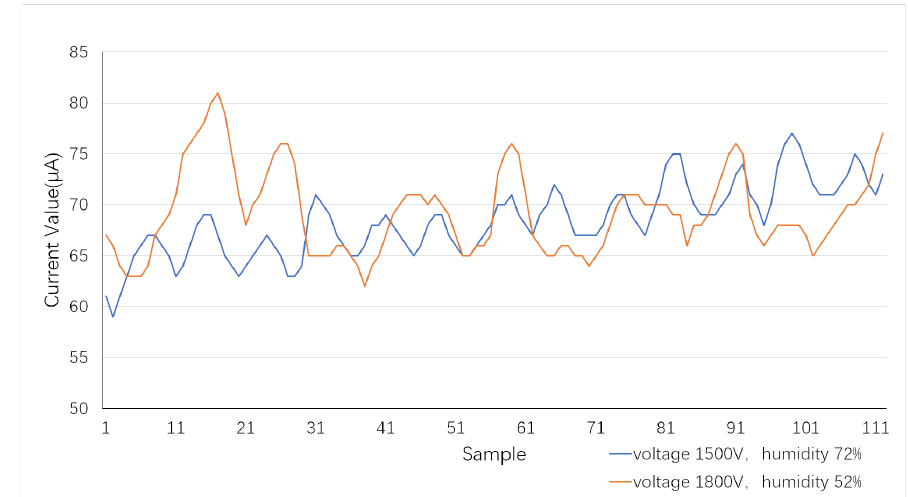
Figure 10. Standard deviation of the current signal of eggs at different